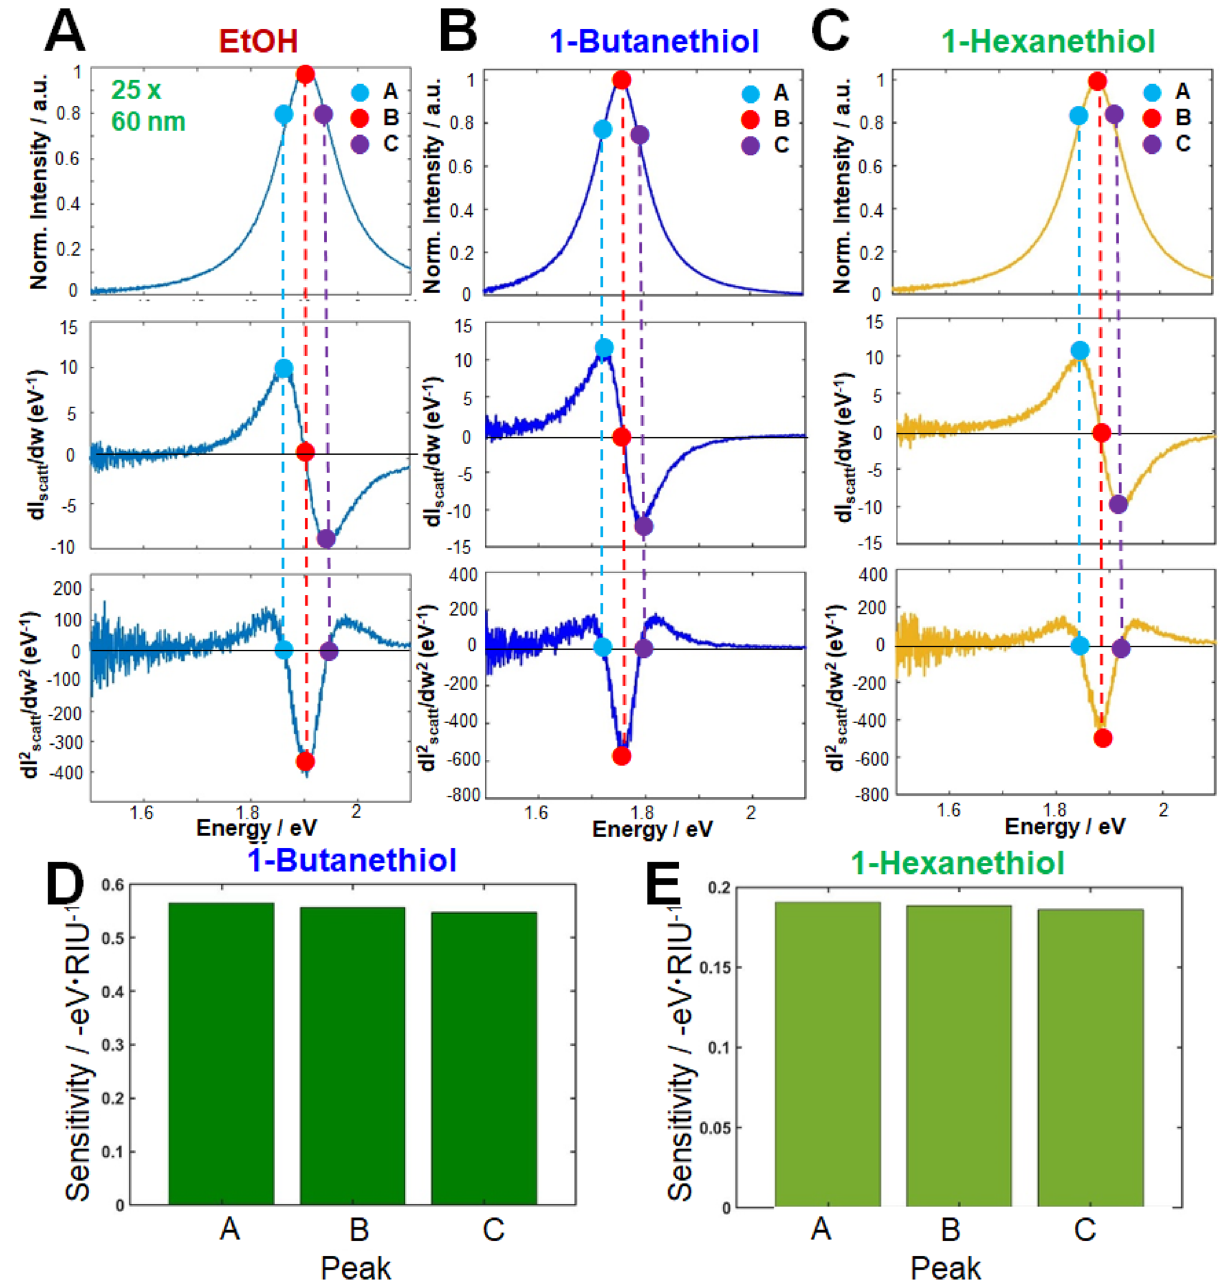
Figure 5. Inflection-point method for single-particle LSPR scattering sensing with AuNRs (25 nm × 60 nm, AR = 2.4) in the presence of 1-alkanethiols (1-butanethiol and 1-hexanethiol) in ethanol: ( A–C ) LSPR scattering efficiencies (first row), and their first-order (second row) and second-order (third row) derivatives; ( D, E ) Detection sensitivities of peak shifts in A, B and